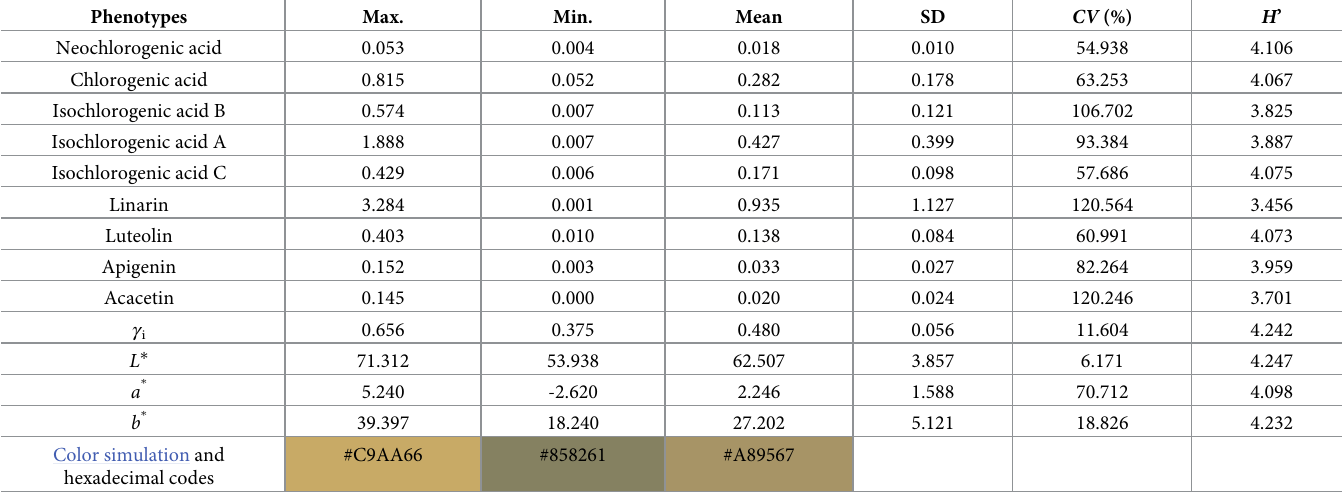
Table 4. Genetic diversity analysis of constituents, γ i , and color parameters of